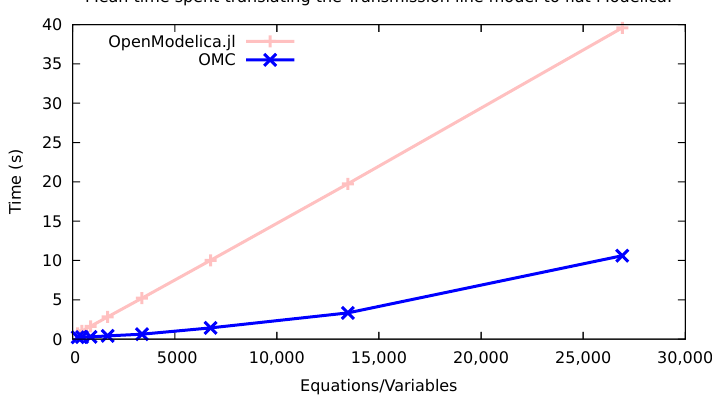
Figure 11. Time spent translating the transmission line model in Listing A5 to flat Modelica for OMFrontend.jl (pink) and for OMC (blue). Lower is